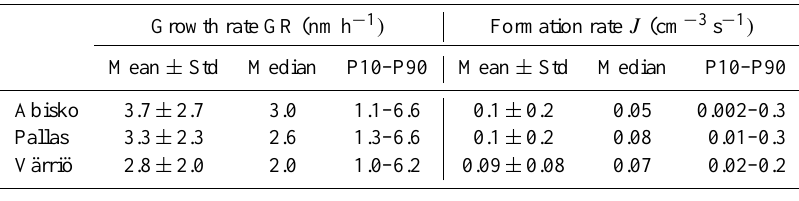
Table 2. Statistics of the properties of NPF events. Calculated means, medians and standard deviations, as well as 10th and 90th percentiles (P10–P90). Here, too, the shorter measurement periods in Abisko prevent direct comparison (see Table 1). Due to different cut-off sizes of the instruments, the formation rates are J 10 , J 7 and J 3 , for Abisko, Pallas, and Värriö, respectively.